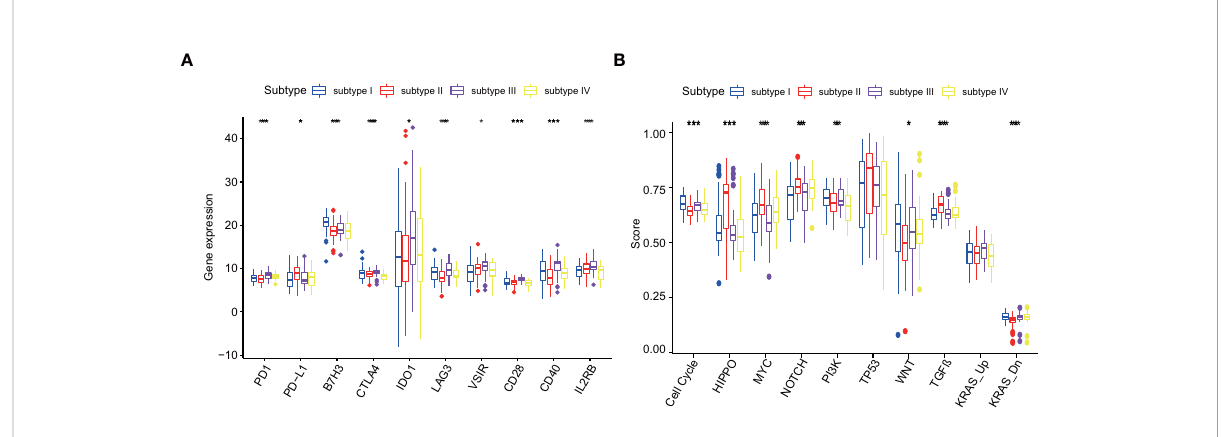
FIGURE 8 (A) Differences in immune checkpoint among four subtypes in GSE53625, p values were showed as: *p < 0.05; ***p < 0.001. ****p < 0.0001. (B) Differences in Cancer pathways among four subtypes in GSE53625, p values were showed as: *p < 0.05; ***p < 0.001. ****p <